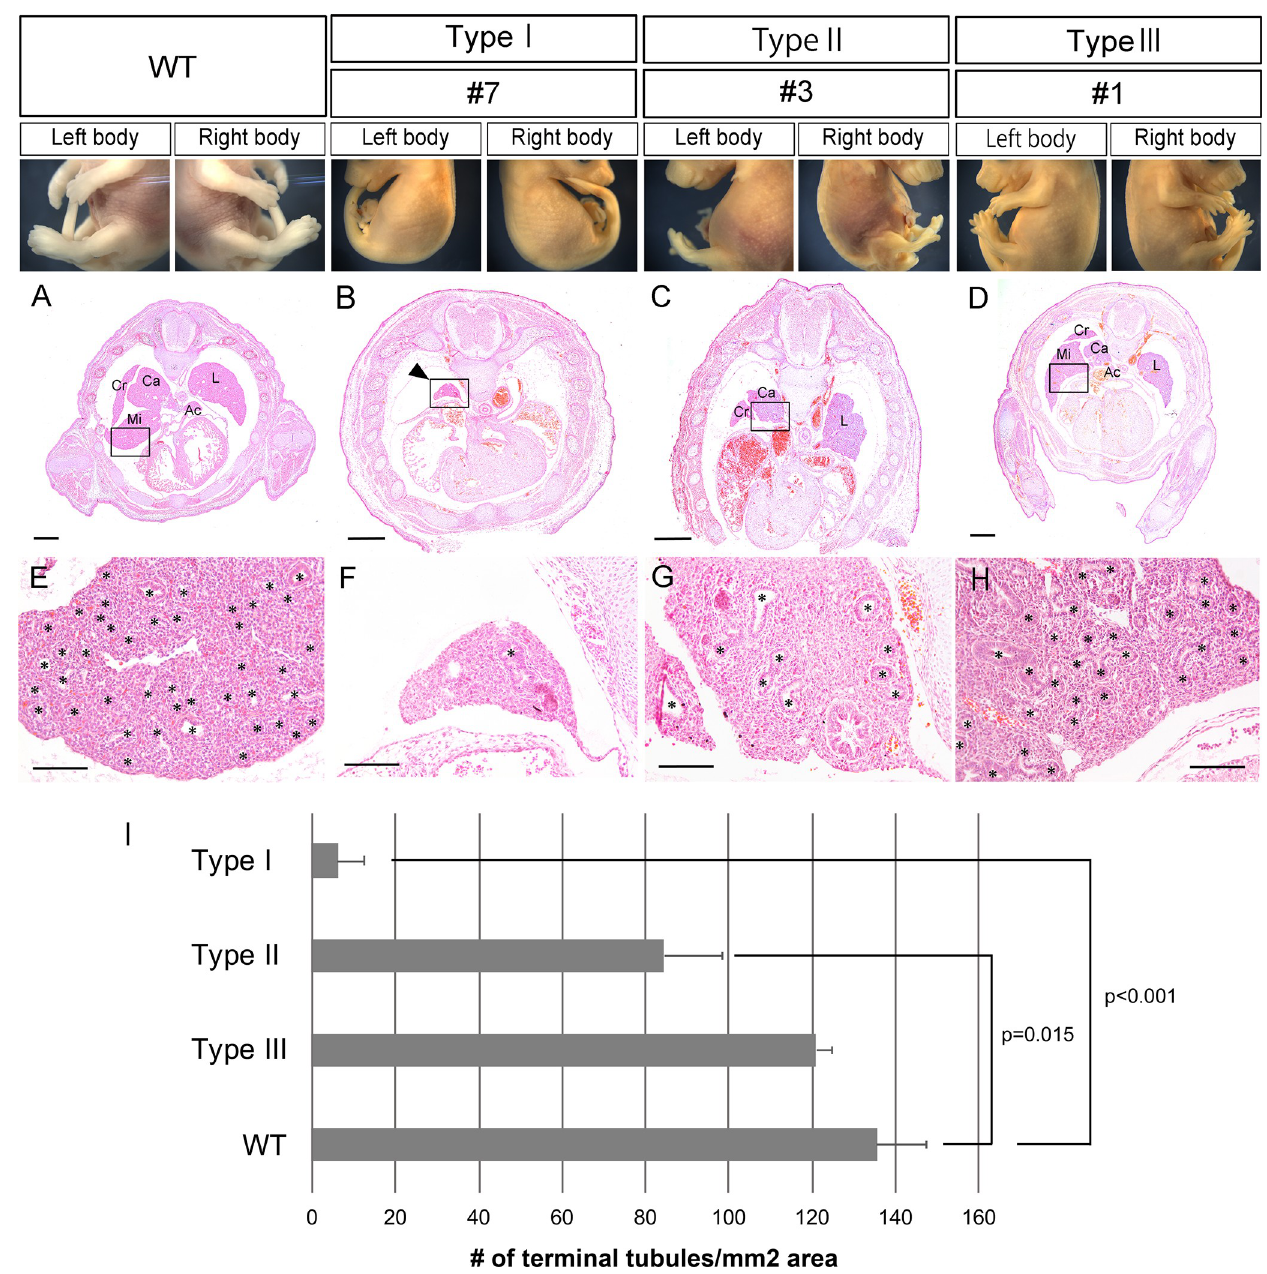
Fig 5. Limb phenotypes and lung histology of Fgf10 -CRISPR F0 embryos at E16.5. Representative embryos are shown for wild type (WT), type I (embryo #7), type II (#3), and type III (#1). A–D , transverse section of the embryonic chest region. E–H , close-up of the embryonic lung (boxed area) shown in ( A–D ), respectively. Asterisks show putative terminal tubules in the lung. I , the number of lung terminal tubules per unit area. In type I and type II embryos, there is a significant decrease in the number compared with that of wild type. Data are presented as means ± SEM. Source data are available in Table 3. Ac, accessory lobe; Ca, caudal lobe; Cr, cranial lobe; L, left lobe; Mi, middle lobe. Scale bars: 500 μ m in ( A–D ), and 100 μ m in ( E–H ). https://doi.org/10.1371/journal.pone.0240333.g005 embryos there was a significant difference in the frequencies of the functional Fgf10 genotypes from the different tissues and in 4 embryos there was no significant difference in the frequen- cies of the functional Fgf10 genotypes from the different tissues (Table 4).